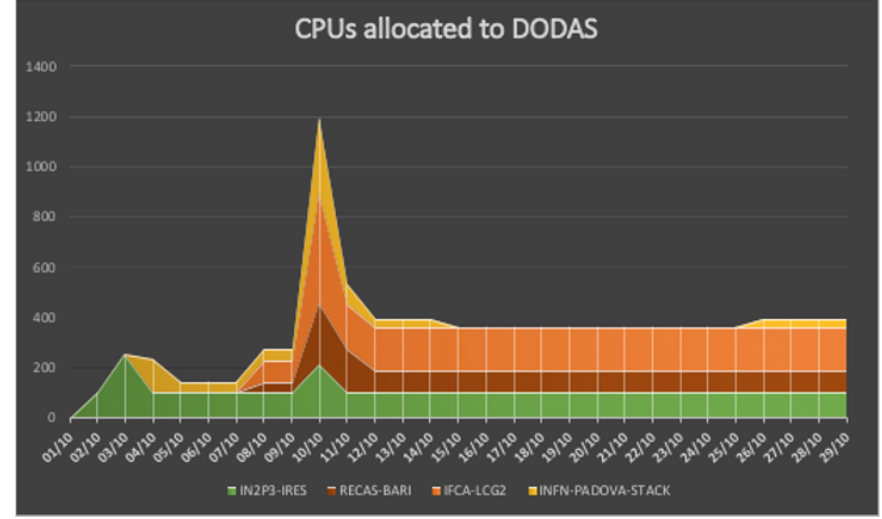
Fig. 3. CPUs allocated to DODAS during the ​